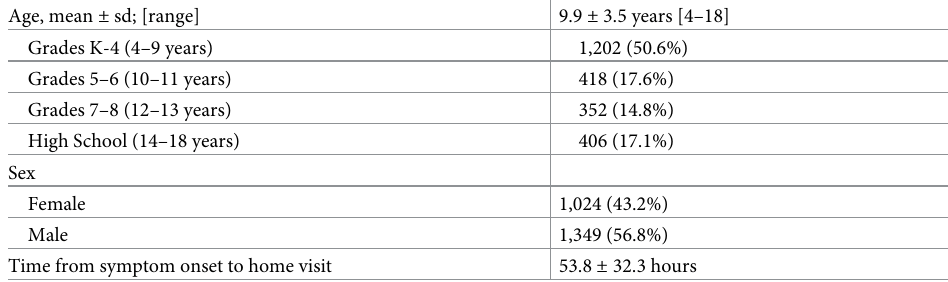
Table 4. Characteristics of 2,378 ORCHARDS student participants in the home